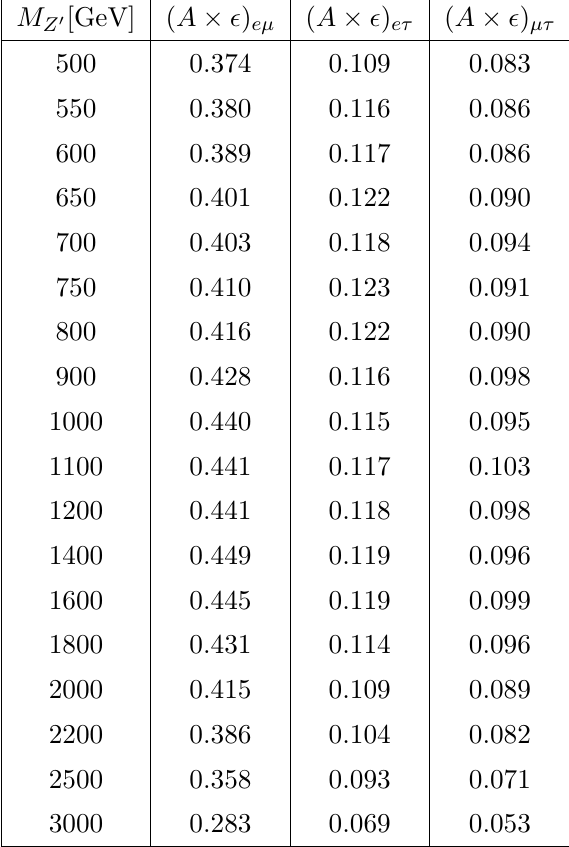
Table 2 . Acceptance times e(cid:14)ciency from SSM Z 0